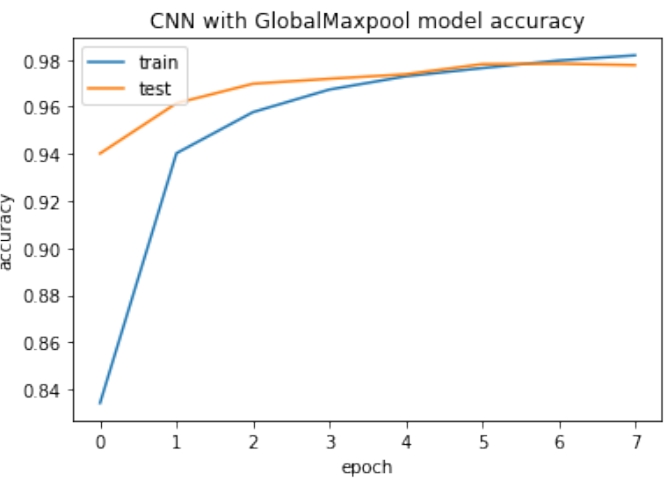
Figure 22. CNN with GlobalMaxpool model accuracy.